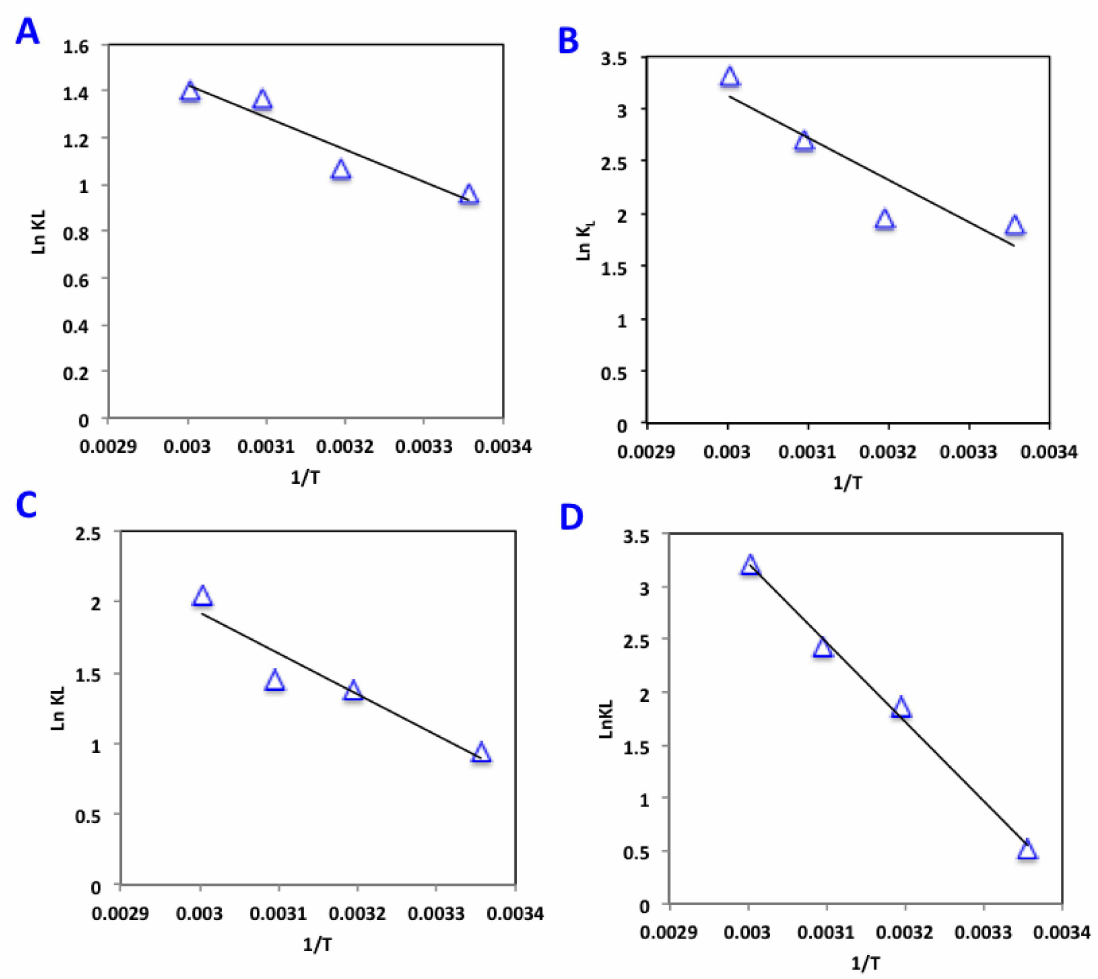
Figure 9. Van’t Hoff plot of lnKL vs. 1/T(K) for phenol adsorption on AS-based materials ( A ) AS, ( B ) AS400, ( C ) AS600 and ( D )